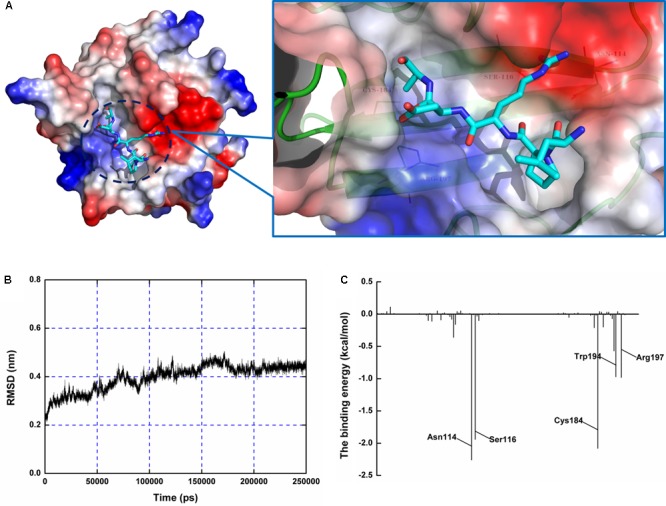
Determination of the 3D structure of the SrtA-oligopeptide complex using a molecular modeling method. (A) The structure of SrtA-oligopeptide. (B) The RMSD calculated for the backbone atoms of the protein during MD simulations of the SrtA-oligopeptide is presented. (C) Decomposition of the binding energy on a per-residue basis at the binding sites of the SrtA-oligopeptide complex.